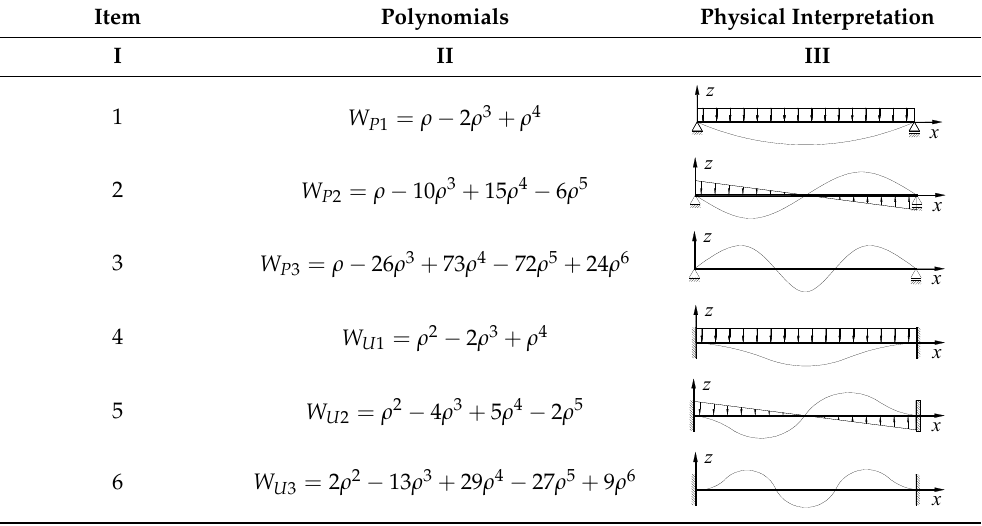
Table 1. Application of polynomials.